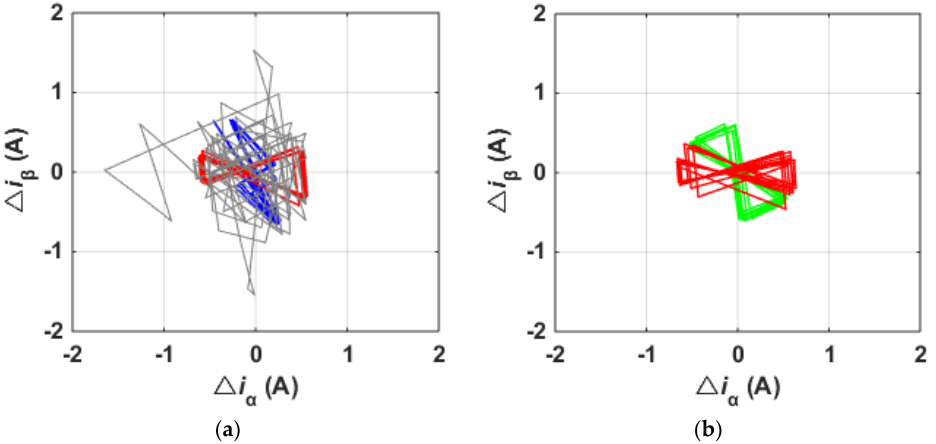
Figure 17. The trajectory of the current error space-vector in the switching point. ( a ) S-FHCC; ( b ) ST-FHCC